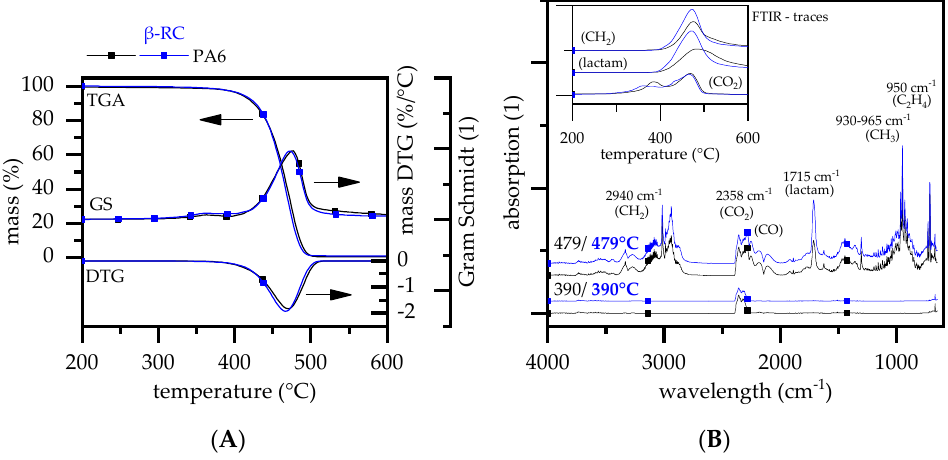
Figure 2. TGA, DTG, Gram Schmidt and FTIR (Gas) curves determined at a heating rate of 20 K/min. ( A ) TGA, DTG Gram Schmidt for net PA6; ( B ) corresponding FTIR peak spectra.